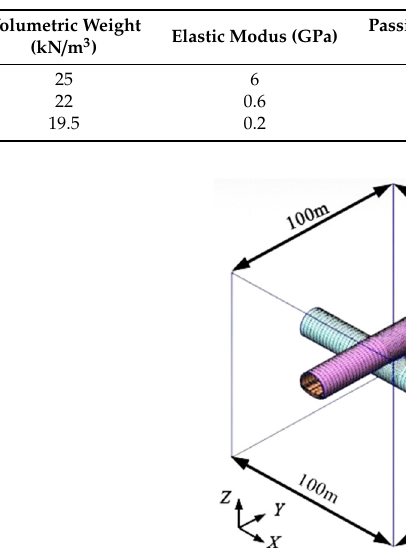
Table 2. Mechanical parameters of strata.